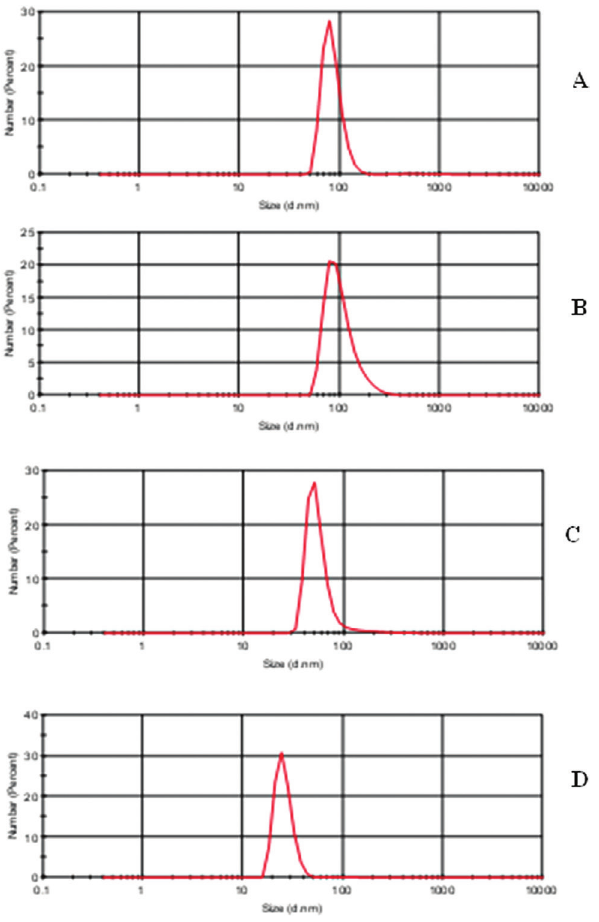
Figure 4: Particle size distribution of the synthesized Ag NPs using E. coli (a), S. aureus (b), B. cereus (c) and S. e. subsp. enterica (d)